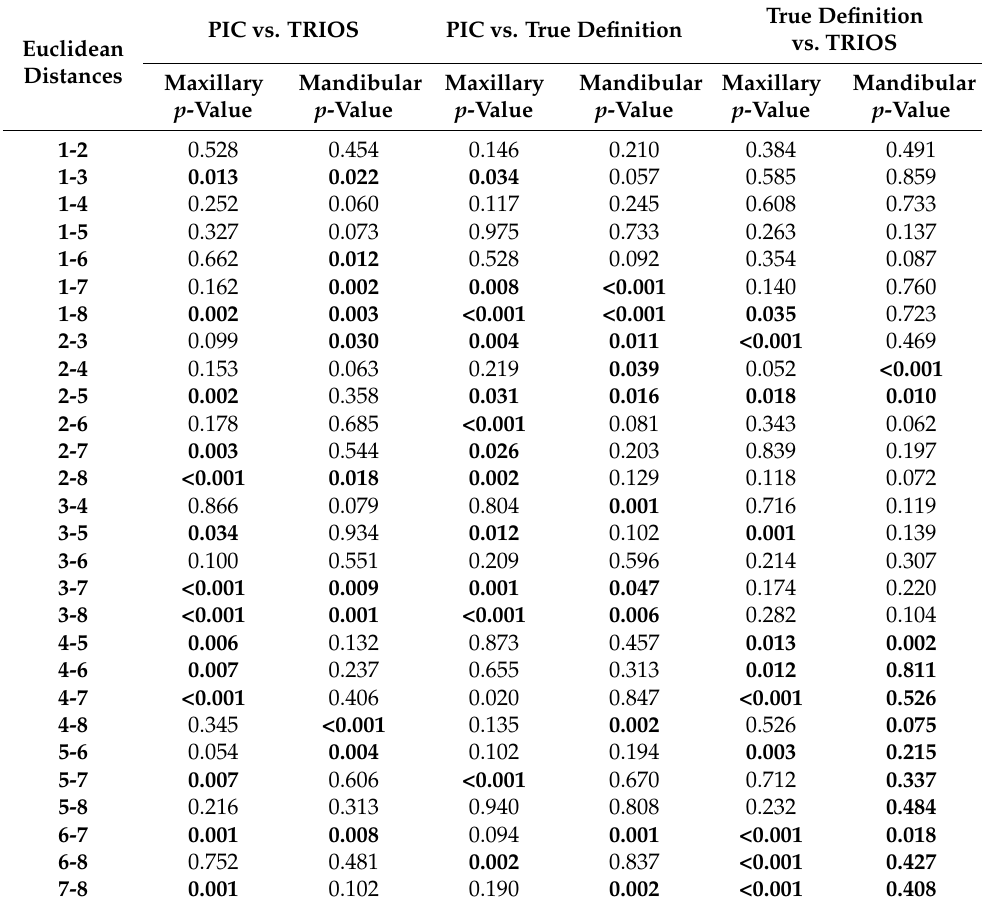
Figure 8. Boxplot showing measurements of relative angulations of abutments of mandibular arch. Abutment 46 is used as reference. Point represents mean error; line represents standard deviation. Table 7. p -values of the comparisons of distance measurements between three IOSs in maxil- lary/mandibular arch. Significant p -values have been highlighted with bold